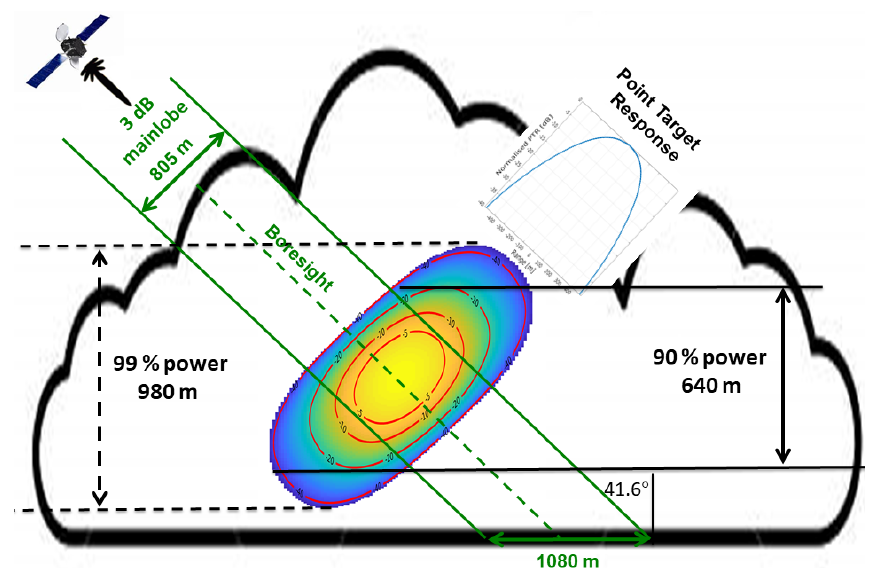
Figure 6. Schematic illustrating the 2D projection onto the antenna elevation cut of the WIVERN observing geometry. The specifics of the radar are detailed in Table 3.